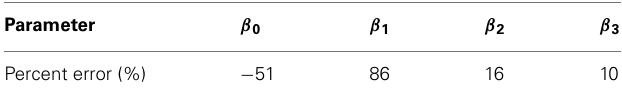
Table 2 | Estimated percent change in variation when switching from equally spaced to log-equally spaced drug